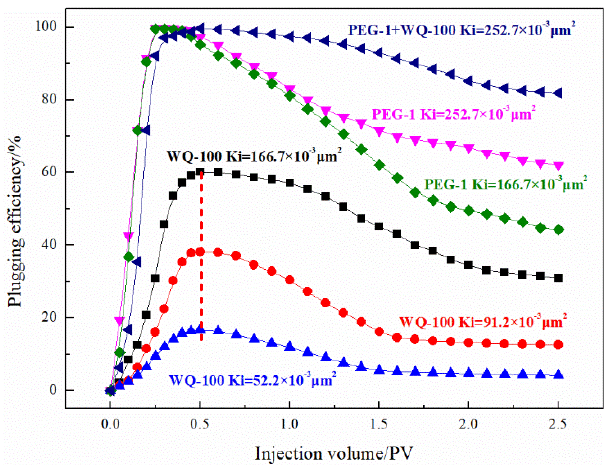
Figure 15. Plugging effects of pre-crosslinking gel particle on the pore-fractured reservoir.